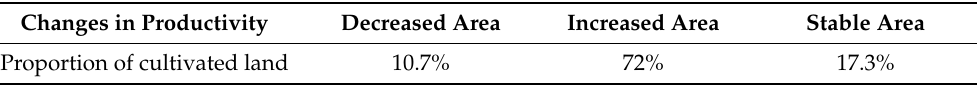
Figure 9. Slope, p, productivity changes, and potential space of the first crop during a double season. ( a ) the slope of the linear regression equation; ( b ) the significance of the productivity changes ( p < 0.05); ( c ) the productivity changes of the first crop; ( d , e ) the productivity potential space of the first crop in the areas where productivity changed. Table 3. Changes in cultivated land productivity in the first crop of a double season.